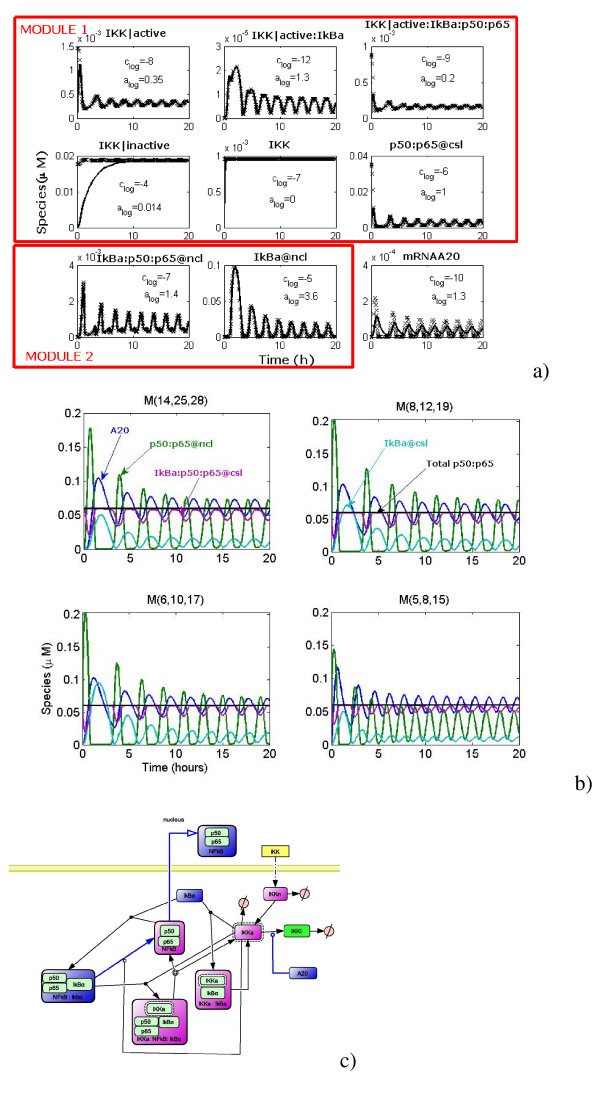
Lipniacki's model a) Testing quasistationarity: nonreduced trajectories (solid), quasi-stationarity trajectories (crosses). b) Trajectories of models in the hierarchy. c) Cytoplasmatic part of the signalling mechanism: terminal species (blue), intermediate species quasi-stationary (pink) non-oscillating (green), simple submechanisms (blue). This part of the network contains three critical parameters for the damping time. Sustained oscillations were obtained by decreasing the constant k3 ten times with respect to the value used in [53] (equivalently, this can be obtained by decreasing k9, or by increasing k4).